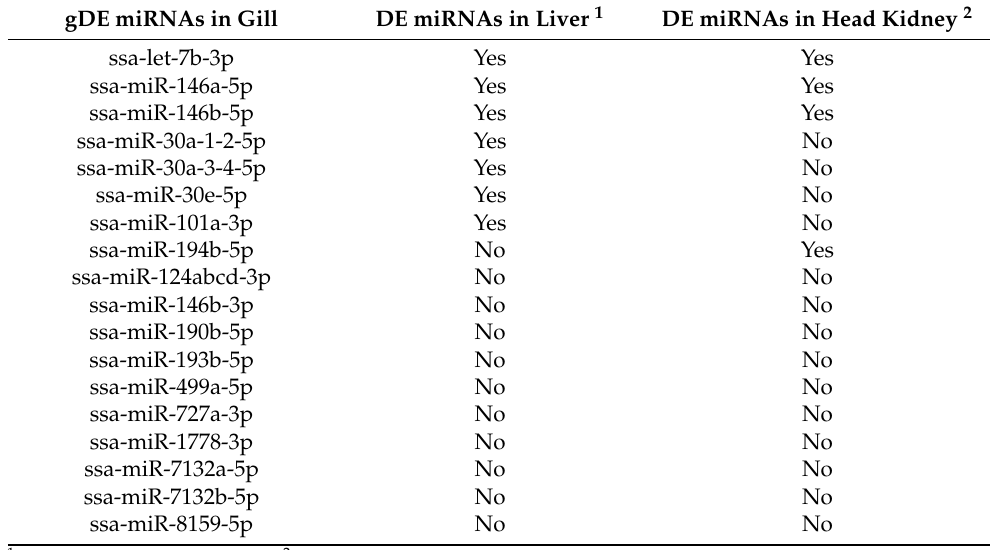
Table 5. gDE miRNAs in the gill and their expression status in similar studies of the liver and HK. gDE miRNAs in Gill DE miRNAs in Liver 1 DE miRNAs in Head Kidney 2 ssa-let-7b-3p